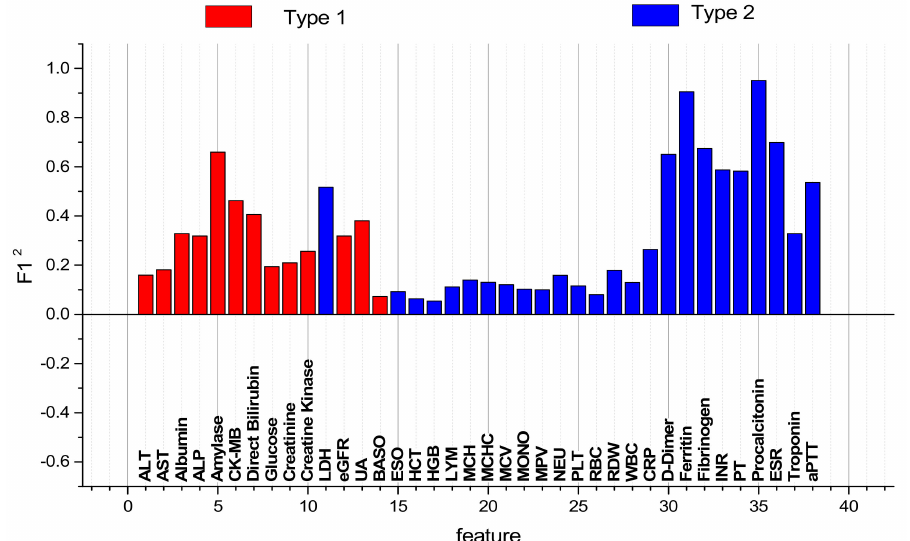
Figure 8. The F1 2 metric for the classification of surviving and non-surviving COVID-19 patients, according to a single feature for the two-threshold approach, with dependency-type visualization (Type 1, Type